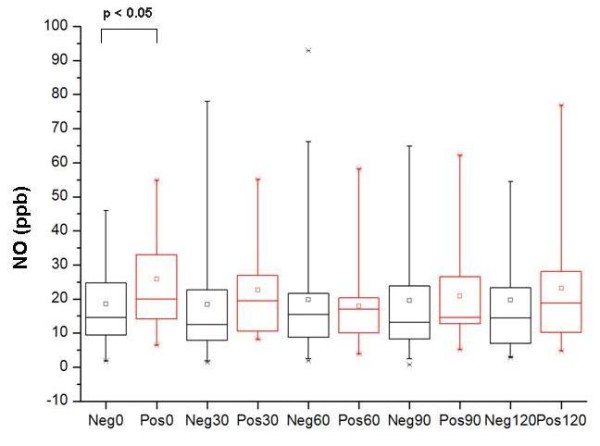
FeNO measurements in ppb before (0 min), and 30, 60, 90 and 120 minutes after the last dose of a food-antigen challenge. The results are grouped at the different time points by food-antigen challenge results, negative (Neg0, Neg30, Neg60, Neg90 or Neg120) or positive (Pos0, Pos30, Pos60, Pos90 or Pos120), and plotted as median value with lower and upper quartiles.